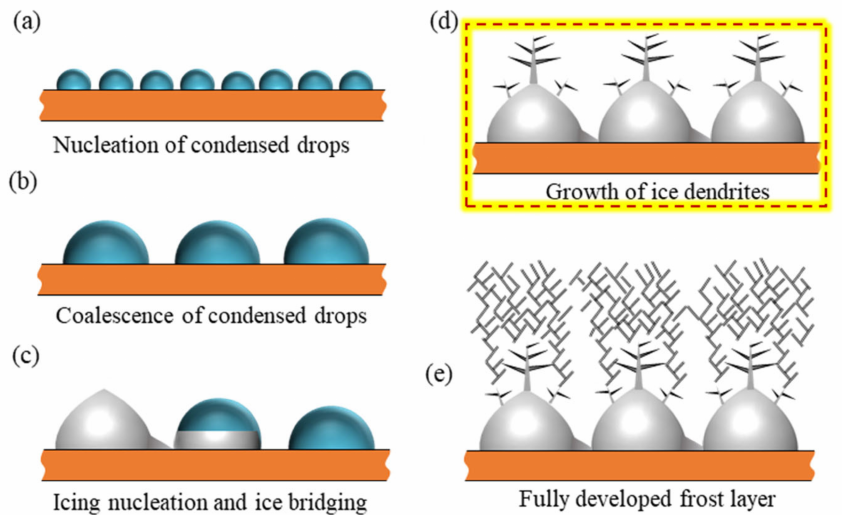
Figure 1. Schematic of the five sequential stages in a typical condensation frosting process [22,23]. The highlighted stage depicts the focus of this